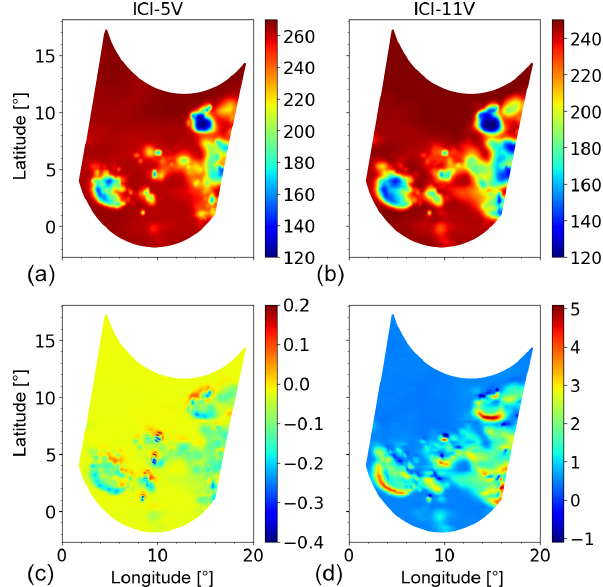
Figure 6. Remapping of ICI-5V and ICI-11V brightness tempera- tures (K) for an example scene. Panels (a) and (b) show simulations representing the expected result after remapping (figures showing the data before remapping look identical plotted in this manner). Panels (c) and (d) display the error found when remapping simu- lated, noise-free